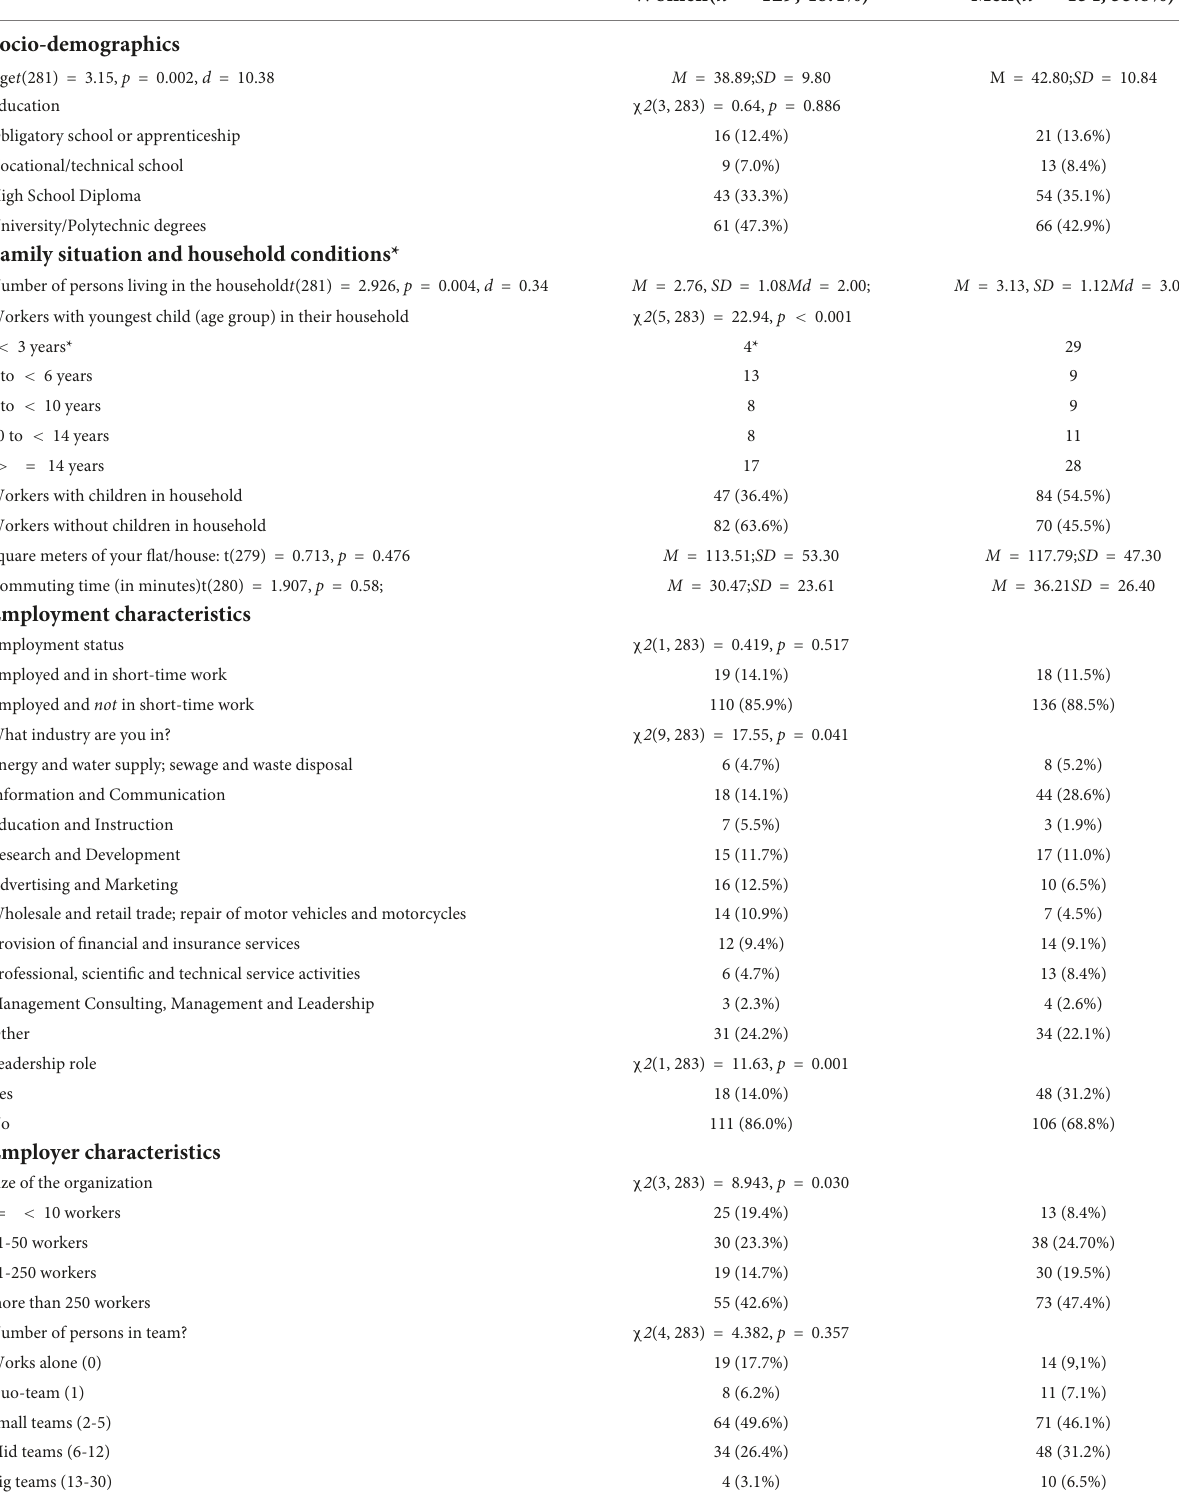
Women( n = 129, 46.4%) Men( n = 154,